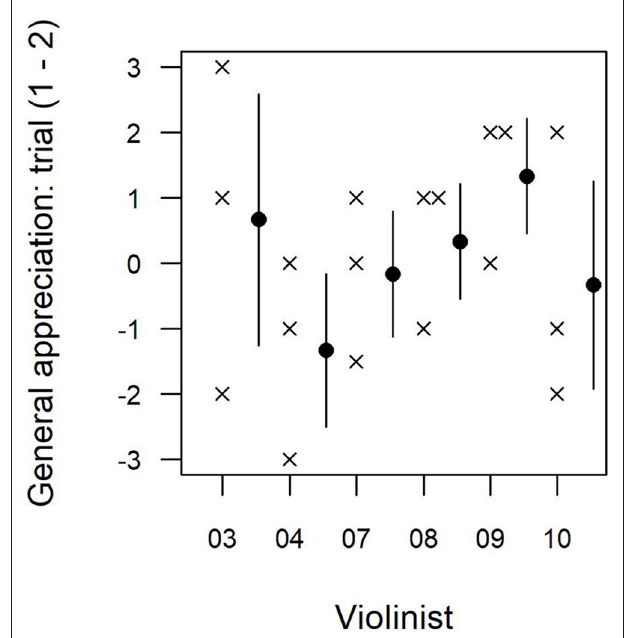
FIGURE 3 | Differences in violinists’ general appreciations for the two tests performed under identical bow conditions (trial 1–trial 2) for six participants (3, 4 and